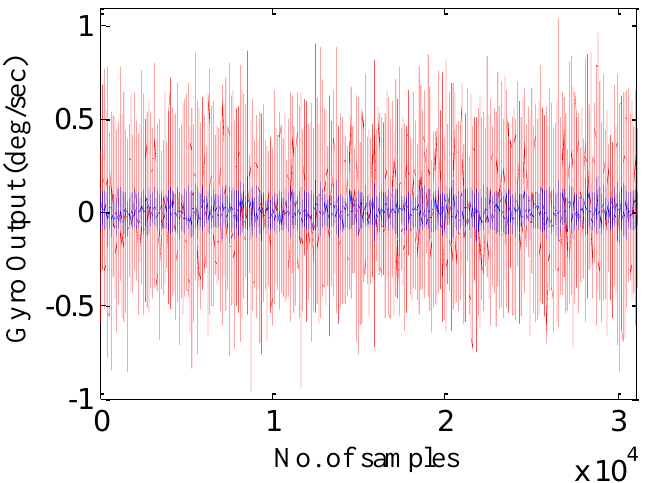
Figure 8. Gyroscope X output, red: uncompensated; blue: compensated using Nu-SVR